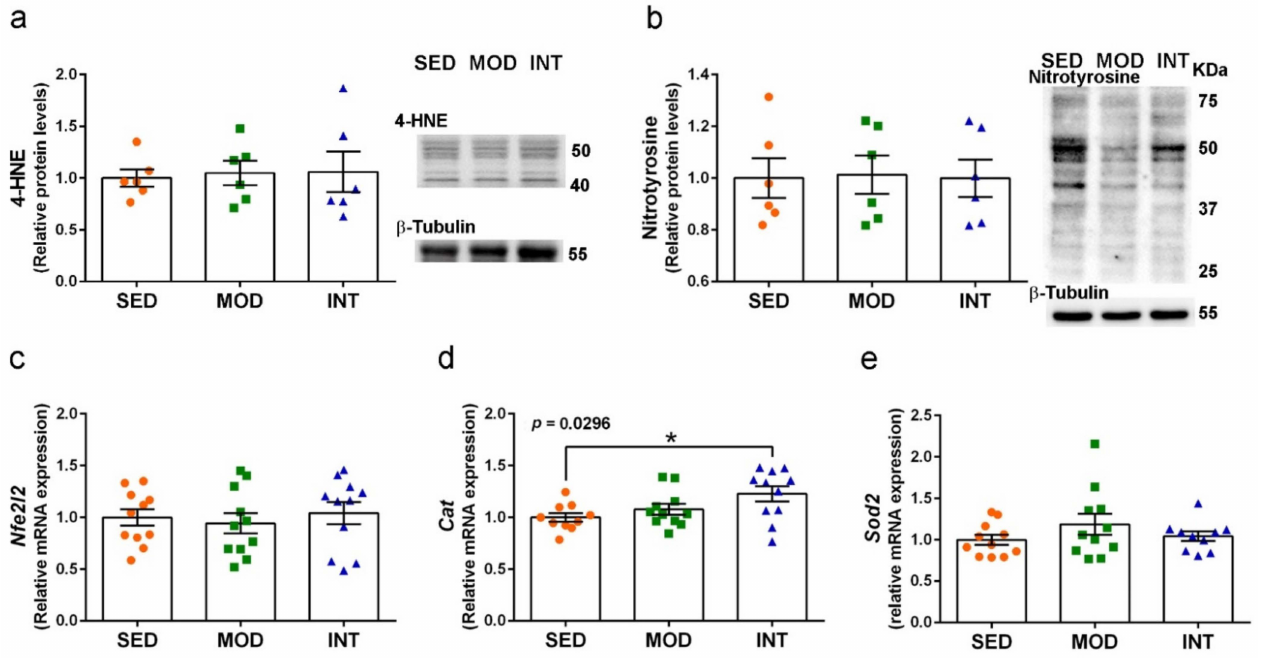
Figure 9. Increase in antioxidant defense and absence of oxidative stress in exercised mice. Levels of proteins labeled with 4-HNE ( a ) and nitrotyrosine ( b ), including corresponding representative blots; mRNA levels of Nfe2l2 ( c ), Cat ( d ), and Sod2 genes ( e ). Analyses were performed on cerebral cortical tissue. Experimental groups: SED (orange circles), sedentary; MOD (green squares), moderate training; INT (blue triangles), high-intensity training. Values are mean ± SEM (( a , b ) SED n = 6, MOD n = 6, INT n = 6; ( c , e ) SED n = 11, MOD n = 11, INT n = 11; ( d ) SED n = 11, MOD n = 11, INT n = 10). Statistics: There was a significant ANOVA effect of exercise treatment in ( d ) with post hoc test * p < 0.05 in comparison to the SED